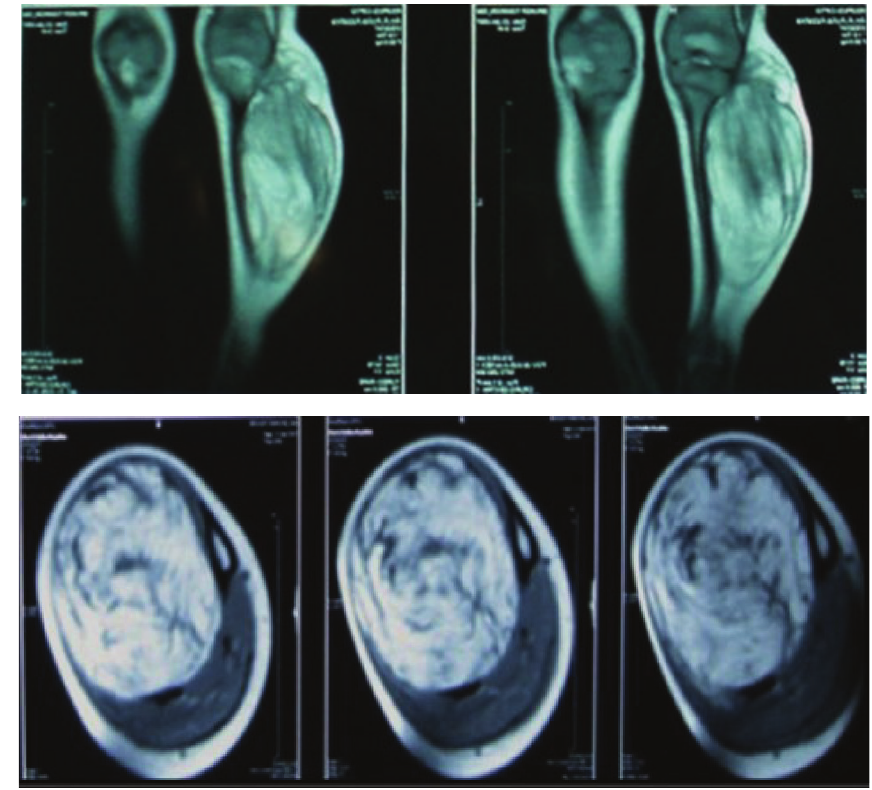
Figure 3: MRI of Case 1 in coronal and axial view of T1-weighted images. The soft tissue mass showed predominantly lipomatous tissue with some part of non-fatty component. The lession was well-circumscribed, with compression of adjacent bones and muscles.